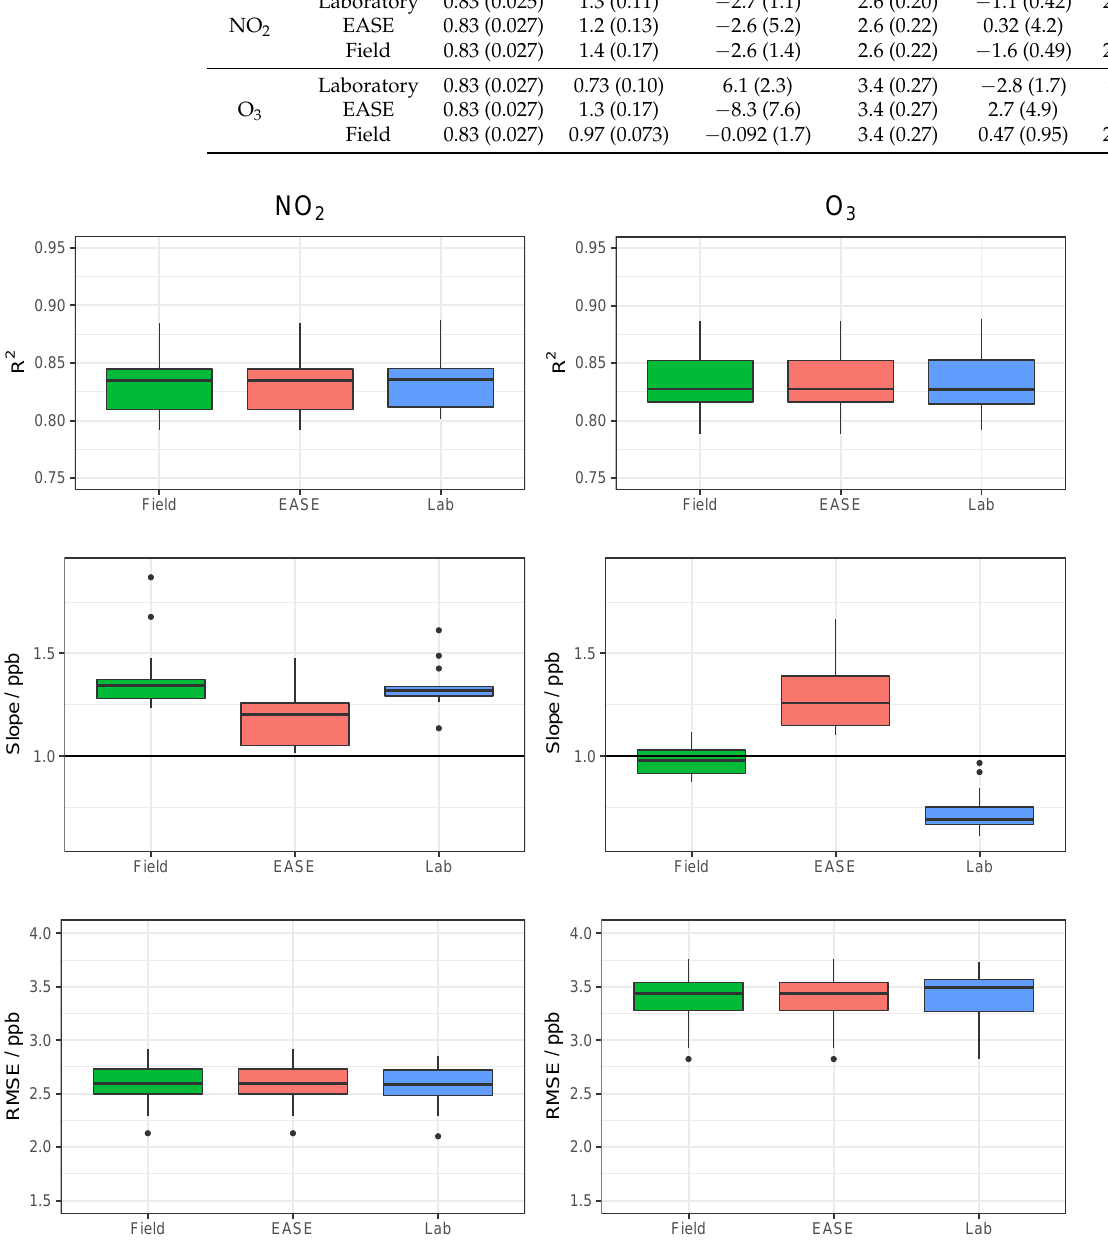
Figure 14. Comparison of R 2 , slope, and RMSE for calibration model validation of EC sensors with the different methods for both NO 2 ( left ) and O 3 ( right ). Lab is short for